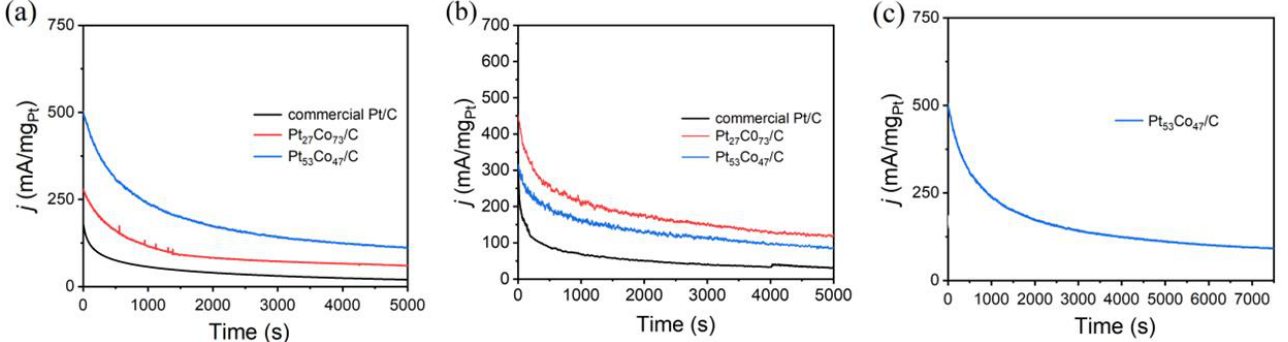
Figure 5. Electrocatalytic durability of the Pt 27 Co 73 /C, Pt 53 Co 47 /C and commercial Pt/C. Current-time curves of these catalysts recorded at 0.65 V. ( a , c ) chronoamperometric tests for MOR in 0.1 M HClO 4 + 0.5 M methanol. ( b ) chronoamperometric tests for EOR in 0.1 M HClO 4 + 0.5 M ethanol. Table 3. Stability comparison of Pt 53 Co 47 NWs/C and Pt-based electrocatalysts for MOR.